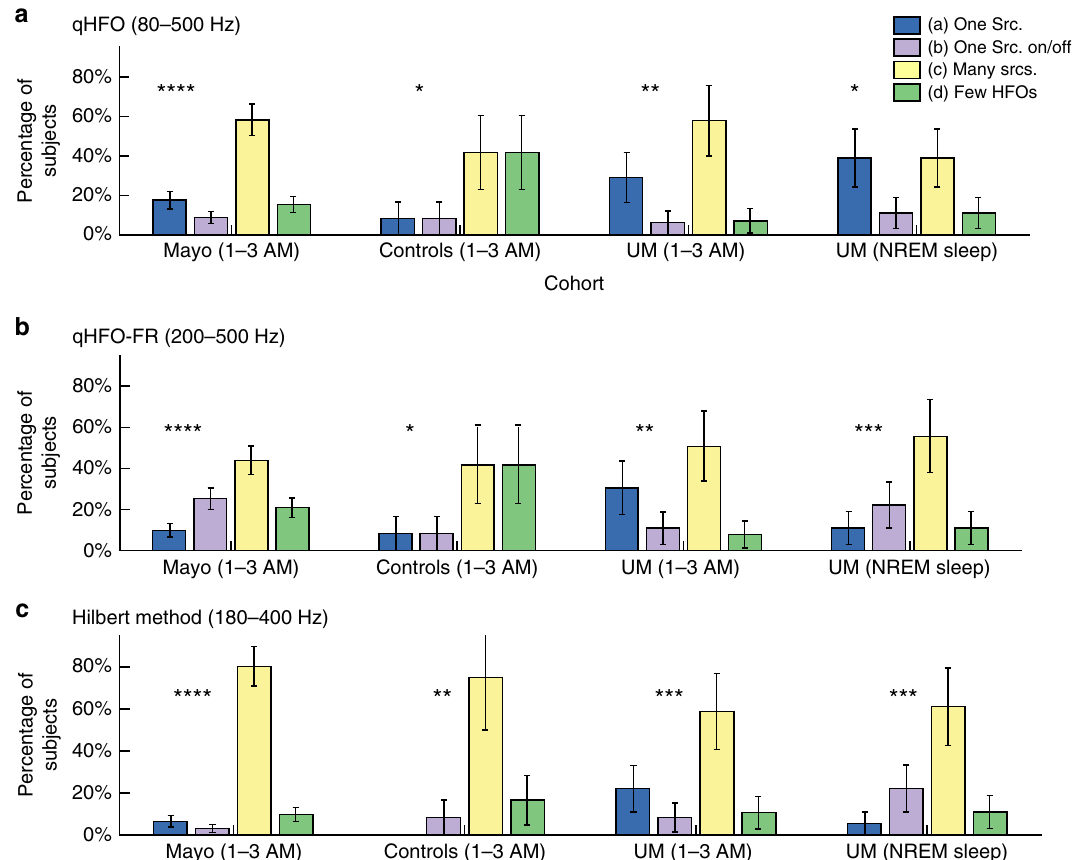
Fig. 6 Occurrence rates for each category of spatiotemporal variability. Occurrence rates are presented separately for each cohort, separating the results from the NREM interictal data and 1 – 3 AM data for the UM cohort. a HFOs detected using standard 80 – 500 Hz bandpass. b HFOs detected using 200 – 500 Hz bandpass for Fast Ripples (FR). c Hilbert-based detector. No statistical difference was found in the percentage of subjects in a given category between any two cohorts (all p > 0.05, χ 2 test). However, in all cases, the category (a) did not account for all patients with measurable HFOs (non-